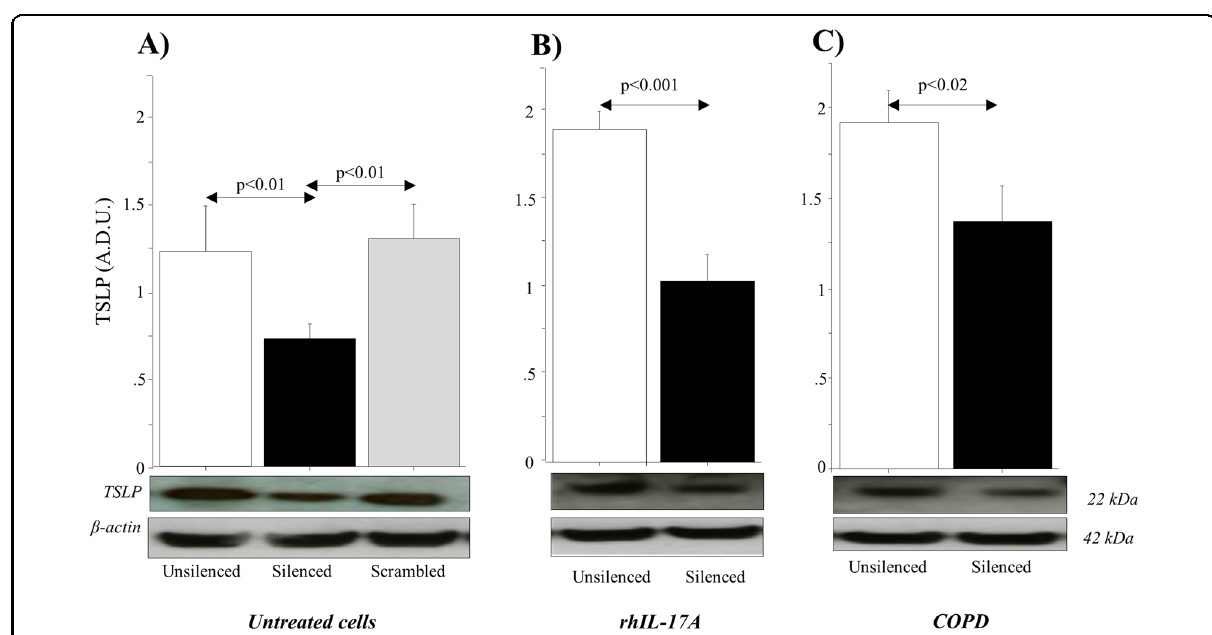
Fig. 5 Effect of IKK α silencing on TSLP protein in 16HBE cells stimulated with rhIL-17A or ISs from COPD patients. a TSLP protein in unsilenced, silenced, and scrambled untreated cells ( n = 3); b TSLP protein in unsilenced and silenced cells stimulated with rhIL-17A ( n = 3); c TSLP protein in unsilenced and silenced cells stimulated with ISs from COPD ( n = 3). TSLP protein was detected by western blot analysis as described in the “ Materials and methods ” section. Bars represent the mean ± SD of arbitrary densitometric units (A.D.U.), normalized to β -actin, which was used as the loading control. Representative gel images of the experiments are shown. ANOVA with Fisher ’ s test correction and the Student t test were used to analyze data. A p value < 0.05 was considered statistically signi fi